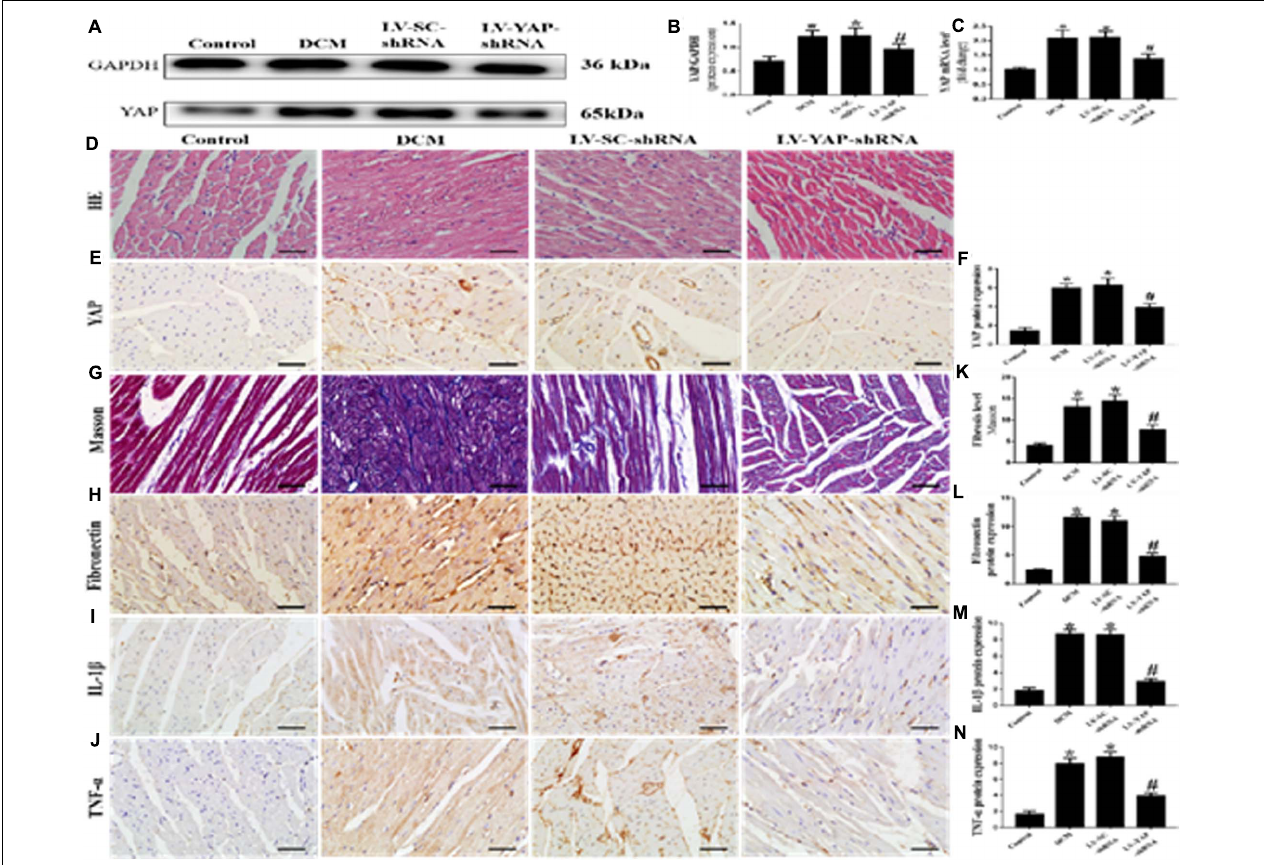
FIGURE 4 | YAP silencing decreased myocardial interstitial fibrosis and inflammation in rats with DCM ( n = 5). (A) Western blot analysis of YAP protein expression in the 4 groups. (B) Quantitative analysis of the YAP protein expression shown in panel (A) . (C) YAP mRNA expression. (D) Representative HE of the 4 groups (scale bar = 20 µ m). (E) Representative immunohistochemical staining of YAP in the 4 groups (scale bar = 20 µ m). (F) Quantitative analysis of the YAP protein expression shown in panel (E) . (G) Representative Masson’s trichrome staining of the myocardium in the 4 groups (scale bar = 20 µ m). (F–J) Representative immunohistochemical staining of Fibronectin, IL-1 β and TNF- α in the 4 groups (scale bar = 20 µ m). (K) Quantitative analysis of the fibrosis level shown in panel (G) . (L–N) Quantitative analysis of the Fibronectin, IL-1 β and TNF- α protein expression shown in panels (H–J) . * p < 0.05 versus the control group; # p < 0.05 versus the LV-SC-shRNA